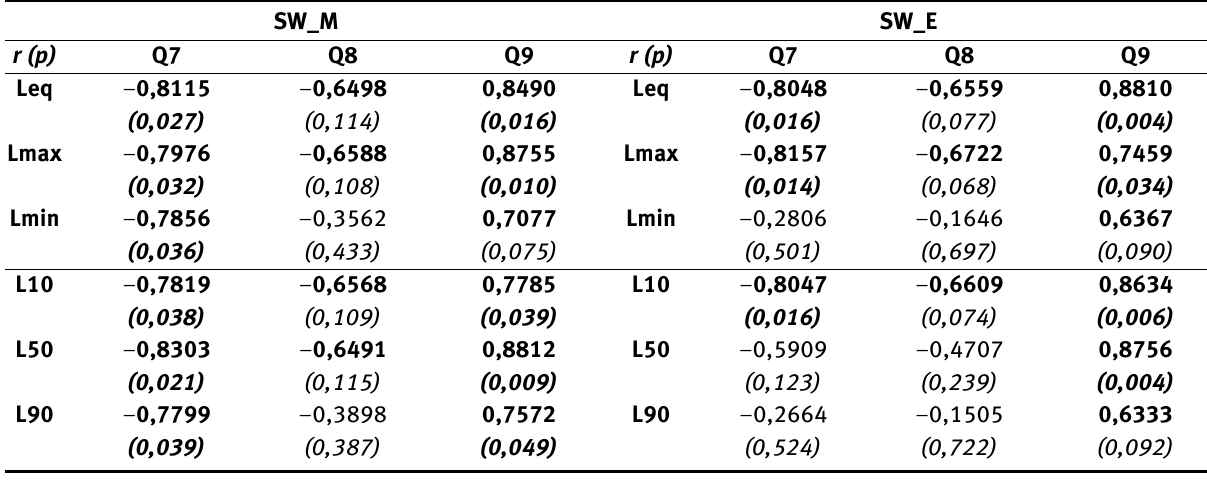
Table 8: Overall quietness (Q7), pleasantness (Q8) and loudness (Q9) correlation vs noise descriptors [Pearson’s correlation coeflcients (r)